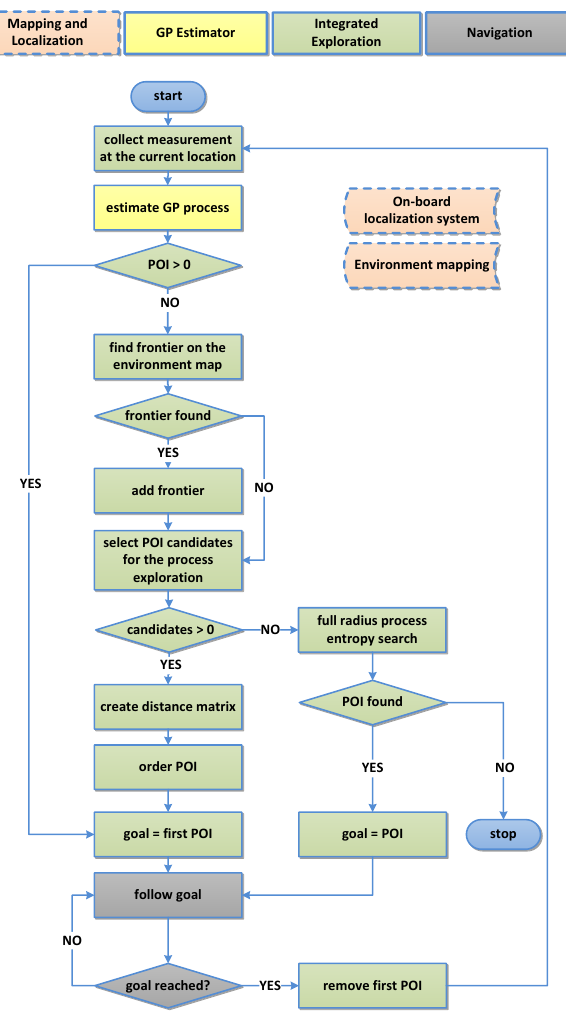
Figure 6. Algorithm state diagram. Colored blocks represent the following: Red—mapping and localization; yellow—estimation of GP; green—core algorithm (our integrated exploration); and